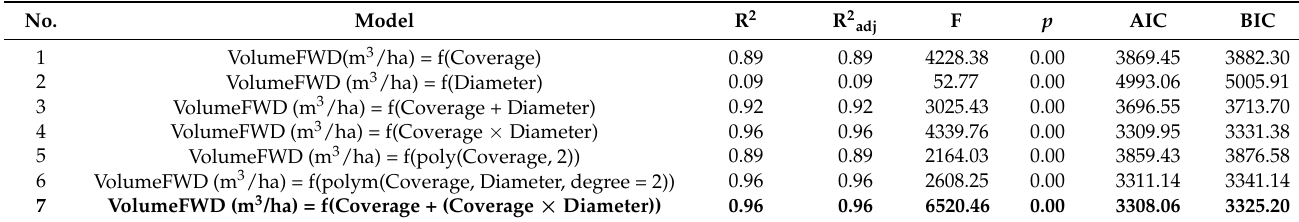
Table 5. Statistical characteristics of models quantifying the volume of fine woody debris (FWD): VolumeFWD(m 3 /ha) = f(x). Coverage represents the proportion of a plot area covered by all dead- wood pieces if placed next to each other given in %, and Diameter is mean diameter of deadwood pieces in mm.